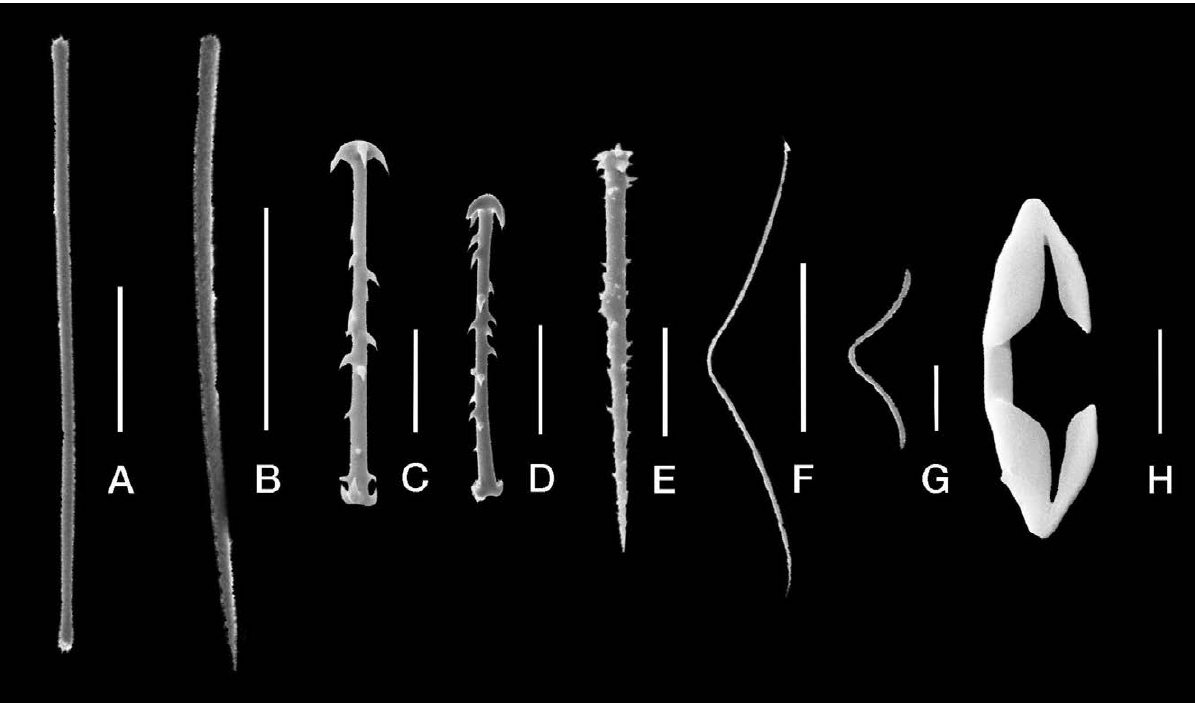
Fig . 3. – Acarnus peruanus van Soest et al ., 1991. A, Ectosomal tylote with microspined heads. B, Choanosomal style. C, Cladoylote I microspined with four clades. D, Cladotylote II microspined with four clades. E, Echinating acanthostyle. F, Toxa I. G, Toxa II. H, Palmate